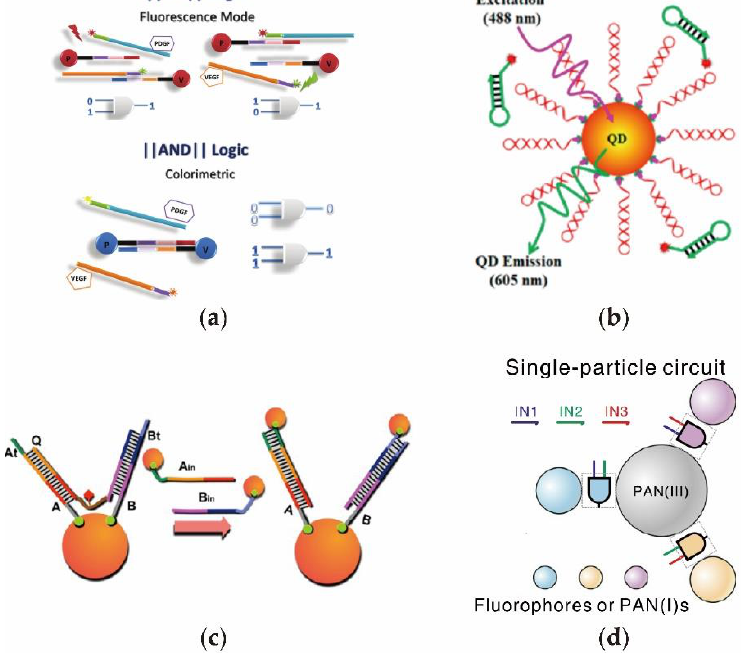
Figure 6. Design of DNA circuits combined with nanoparticles ( a ) DNA circuit directing the aggregation of gold nanoparticles to detect the target protein. ( b ) Catalytic DNA circuit on quantum dots to detect low-concentration target microRNA. ( c ) Multiple-layer DNA circuit on gold nanoparticles. ( d ) Programmable nanoparticle-assisted DNA logic circuit.